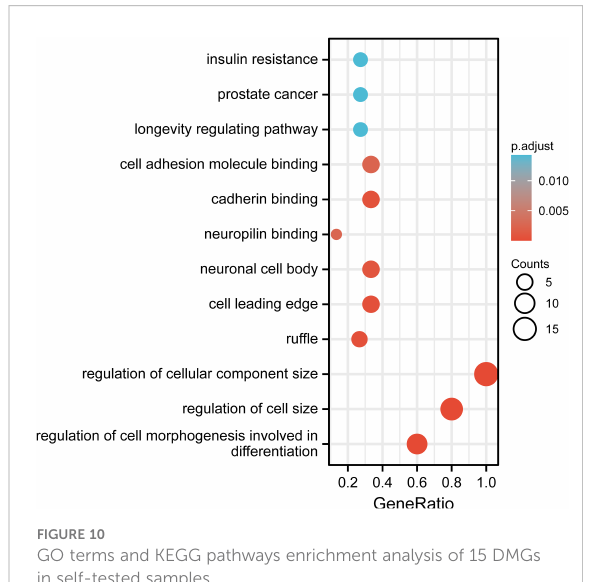
FIGURE 10 GO terms and KEGG pathways enrichment analysis of 15 DMGs in self-tested